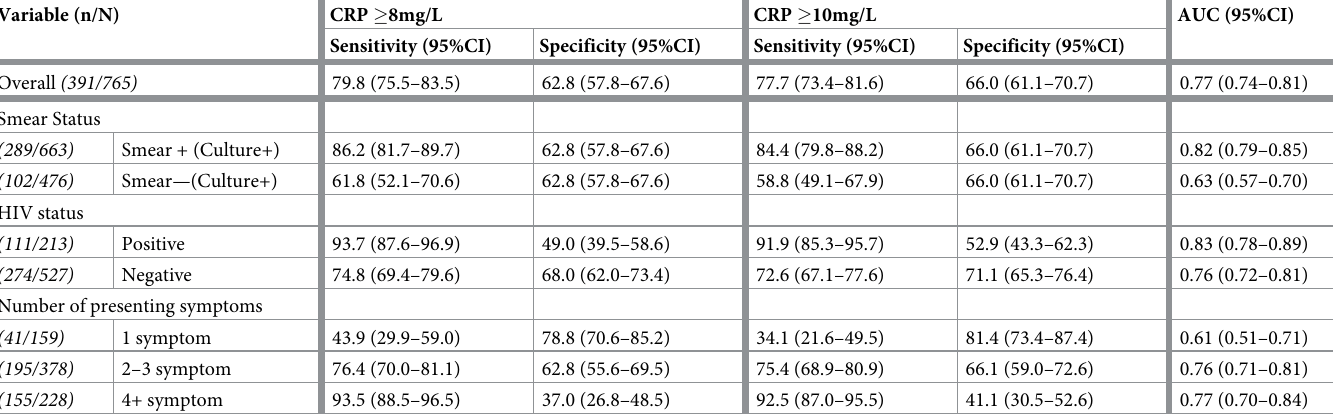
The optimal cutoff-point was markedly different in HIV+ and HIV- participants, although the difference in the AUC between these two populations was not significant. For HIV- Table 3. Sensitivity and specificity of CRP in the diagnosis of culture-positive